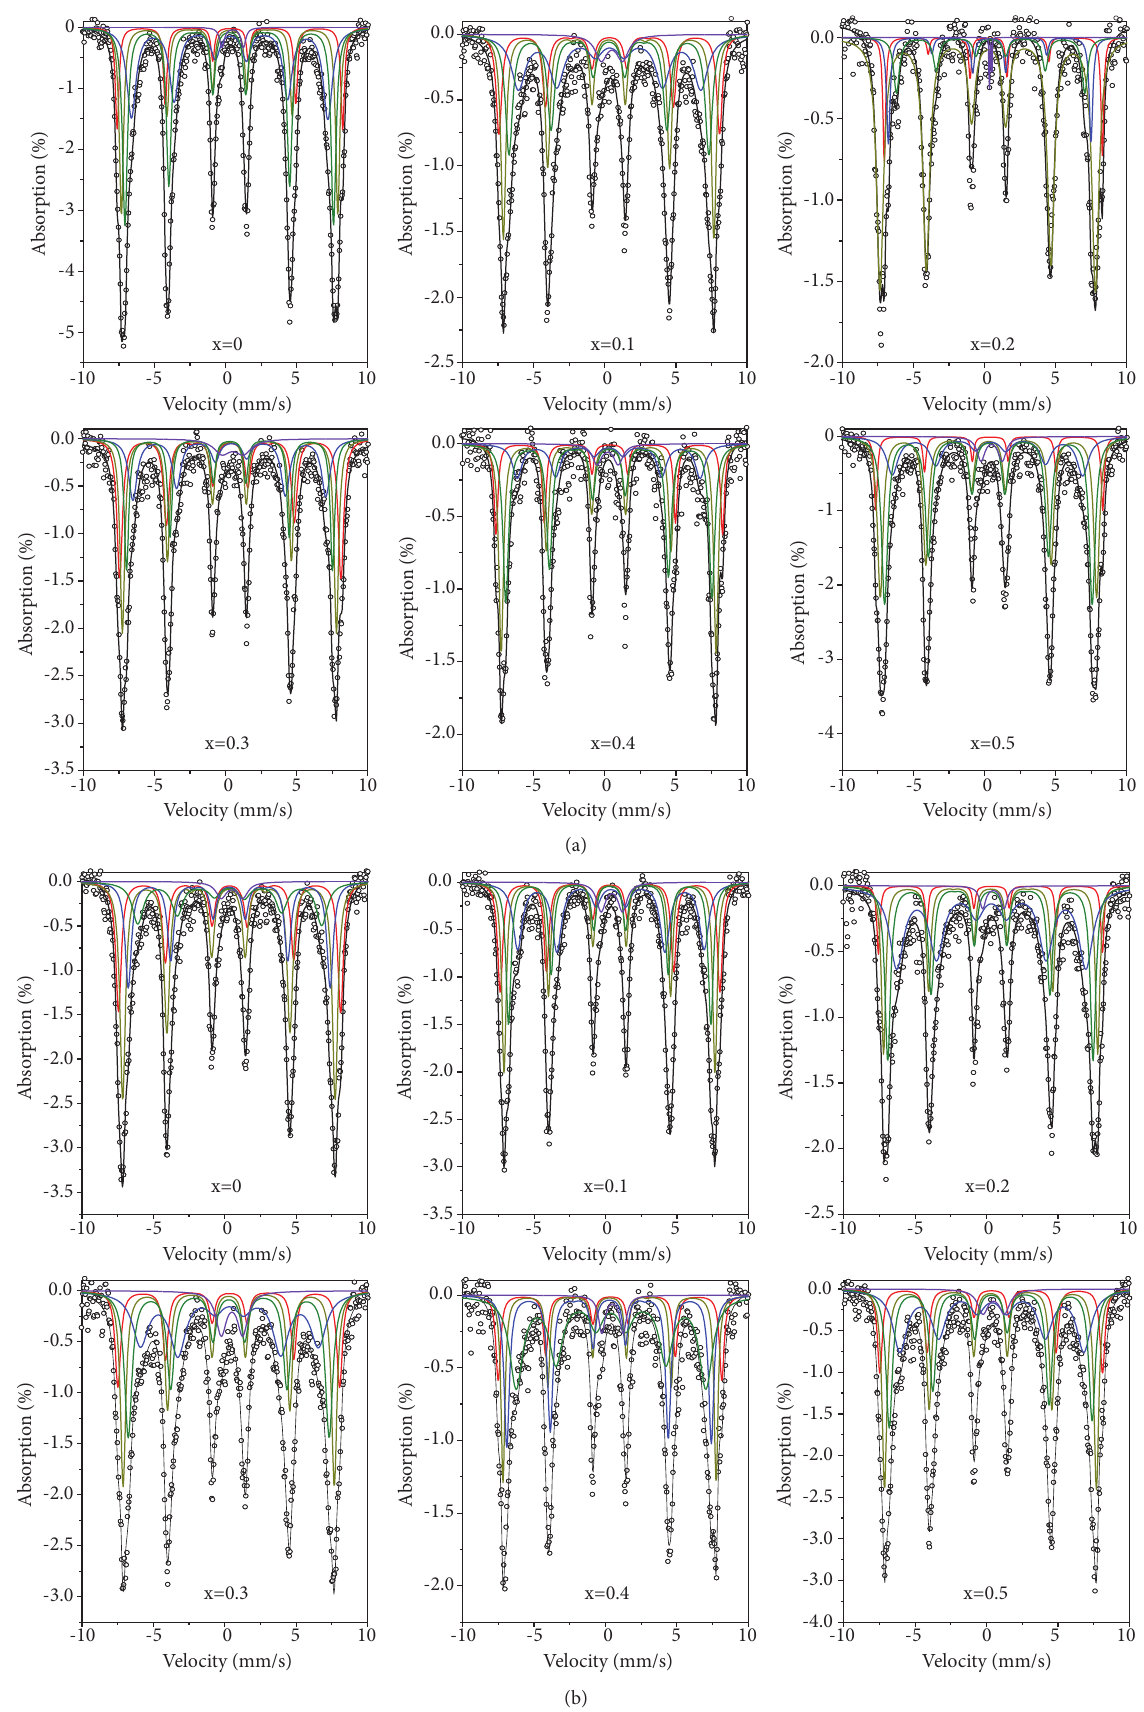
Figure 4: M ¨ ossbauer spectra of (a) furnace-cooled and (b) quenched Mg